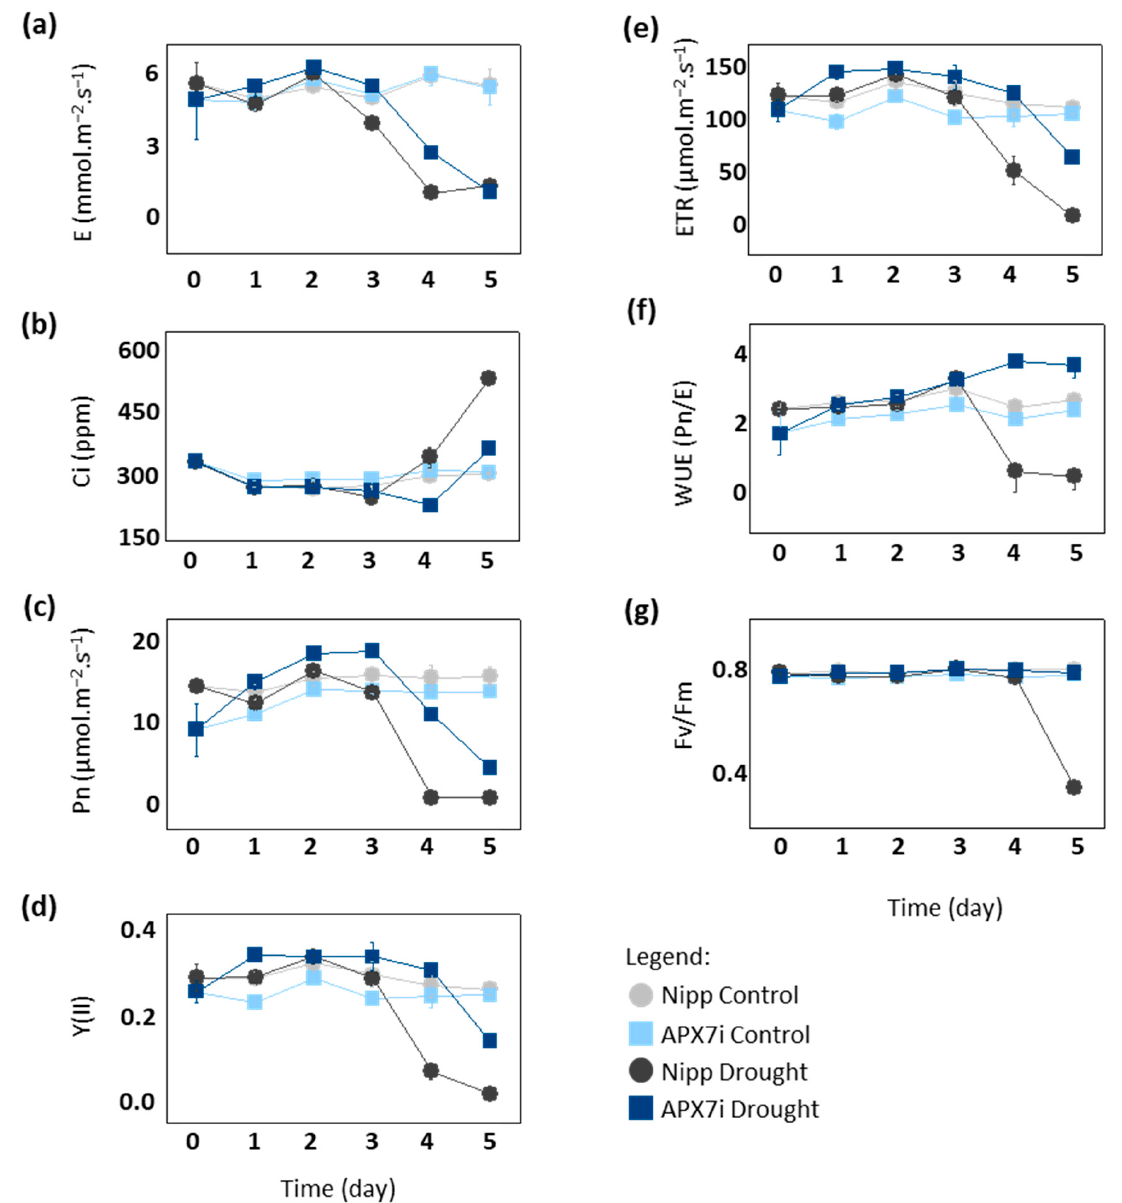
Figure 6. Photosynthetic and fluorescence parameters in plants subjected to drought stress. ( a ) transpi- ration, ( b ) intracellular CO 2 , ( c ) net photosynthesis, ( d ) quantum yield of photosystem II, ( e ) electron transport rate, ( f ) Water use efficiency, ( g ) Potential quantum use efficiency of photosynthesis (Fv/Fm) in Nipponbare (grey) and APX7i (blue) leaves. Light colors indicate the measurement in plants under control conditions. All values represent the media ± SE of at least three independent